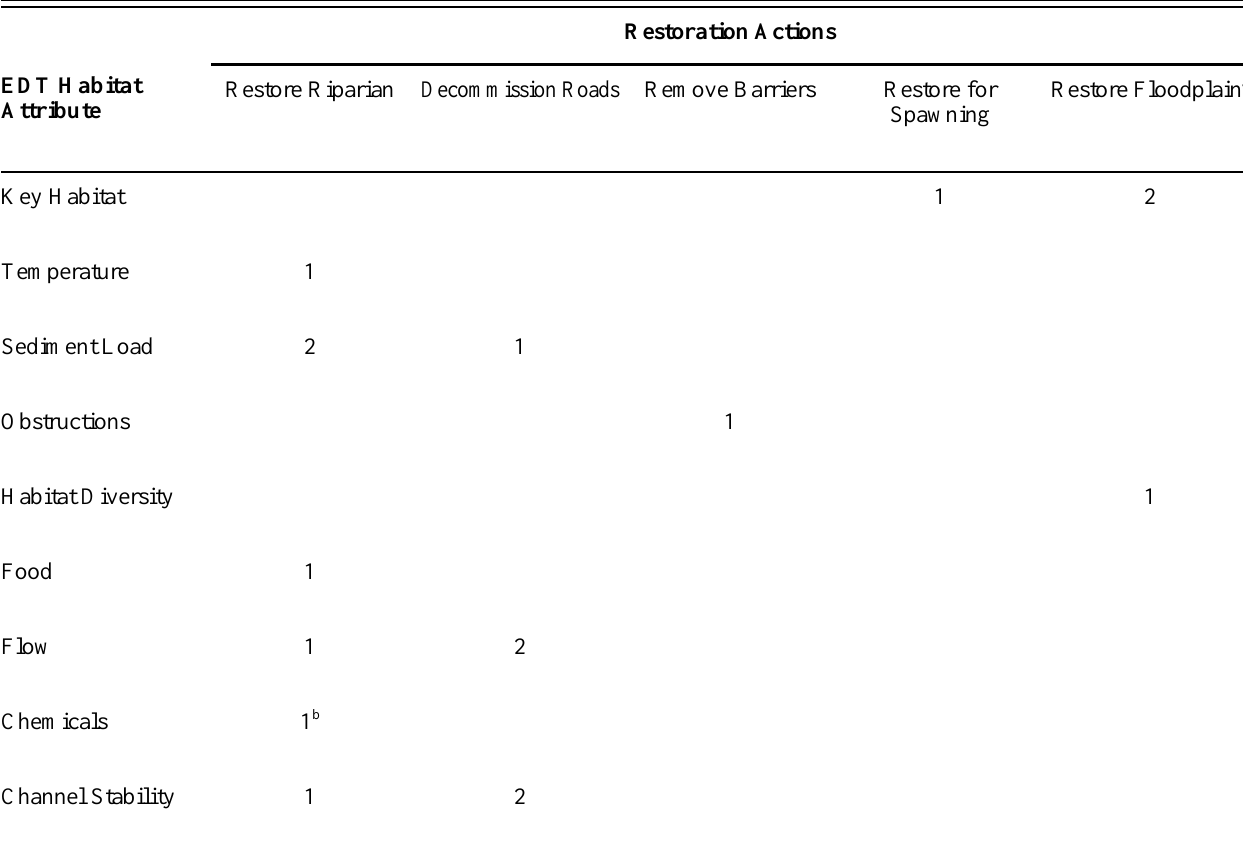
Table A2 . Translation from EDT model output for current conditions within each reach prioritized for restoration or preservation to the EDT watershed management strategy. Fifty percent of the funds were spent on restoration actions. Habitat attributes identified by EDT, by reach, as the most important were “fixed” first. Numbers in each cell represent the prioritization of restoration actions within each row. If there were two habitat attributes that were most limiting, we started with the cheapest problem to fix. All protection funds were spent on riparian protection or restoration. If the current riparian condition was good (as rated by the remotely-sensed riparian model in Table 4), riparian conditions were protected. If the current condition was fair or poor (as rated by the remotely-sensed riparian model in Table 4), riparian conditions were restored.